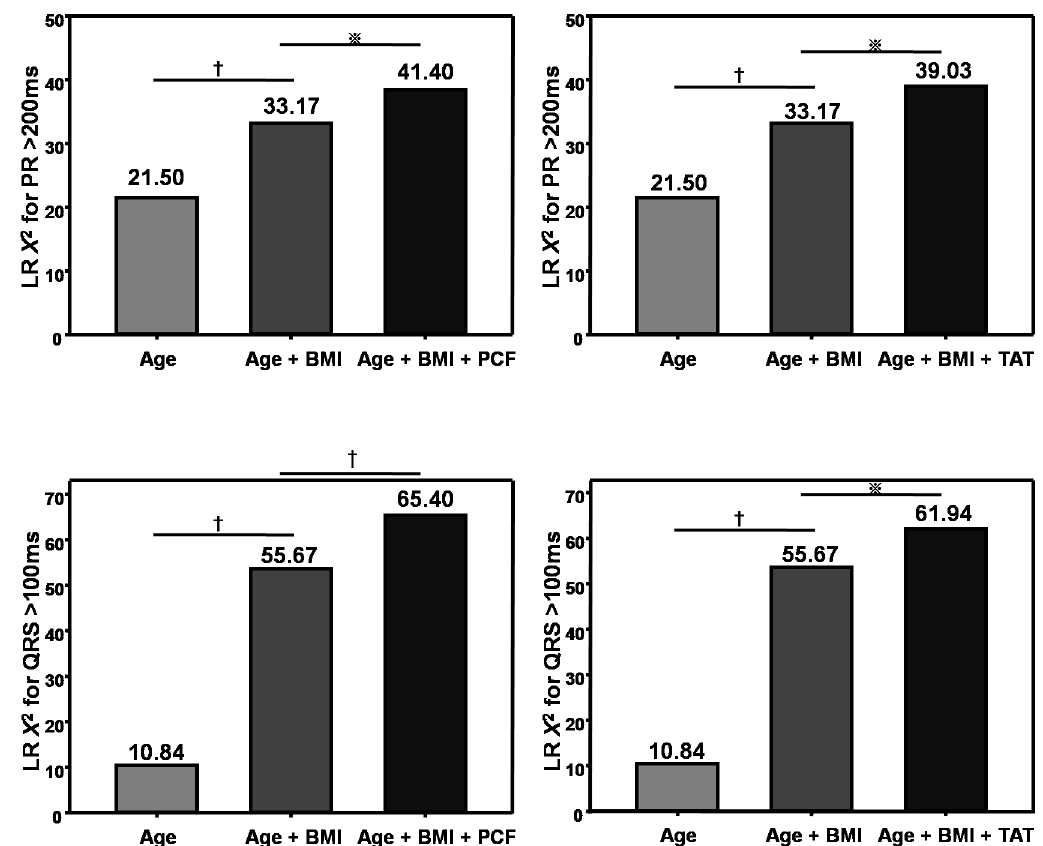
Fig 3. Likelihood ratio tests demonstrated the incremental value of PCF and TAT in identifying body surface 12-leads ECG anomaly, including prolonged PR interval ( > 200ms) and QRS duration ( > 100ms) when superimposed on age and body size measure in terms of